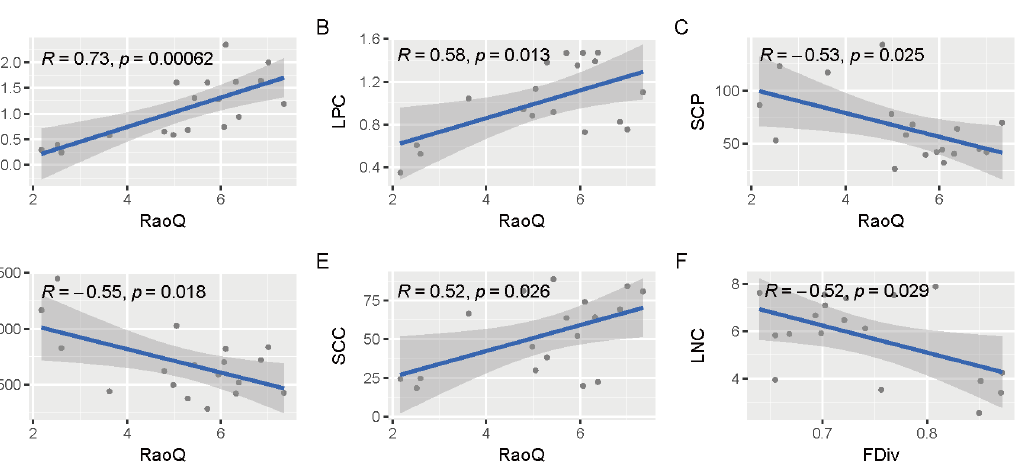
Figure 7. Linear plots of the correlation between functional diversity and leaf and soil properties. R represents the magnitude of correlation between the two variables, p represents the magnitude of